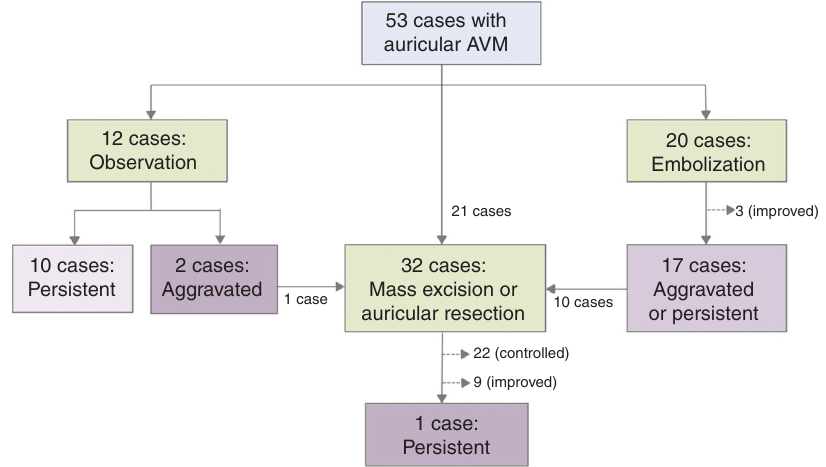
Figure 4 Flow chart of the treatment of 53 patients with auricular arteriovenous